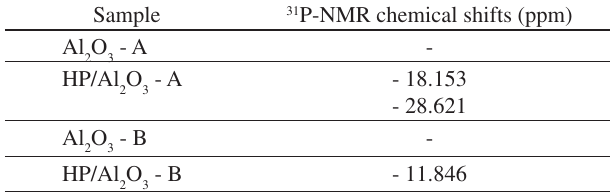
Table 2. Chemical shifts from 31 P NMR.